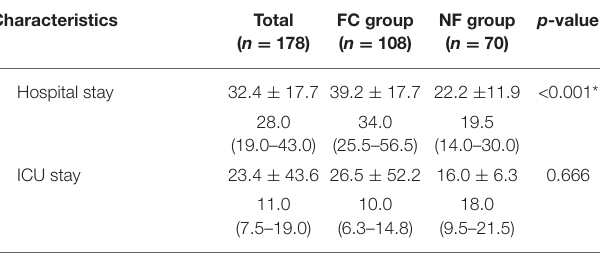
TABLE 2 | Comparison of initial laboratory findings between FC and NF